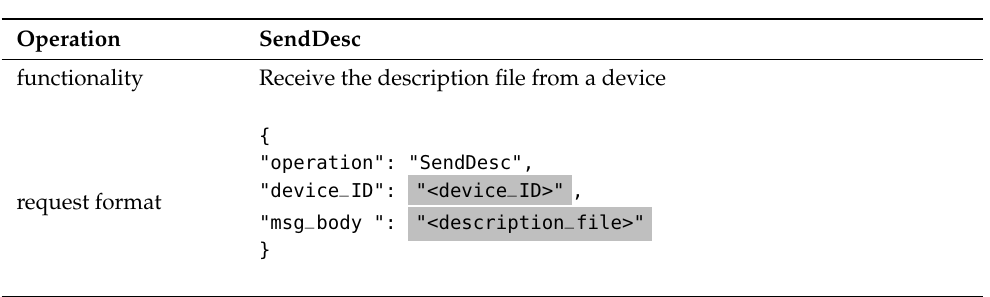
Table 6. SendDesc operation.